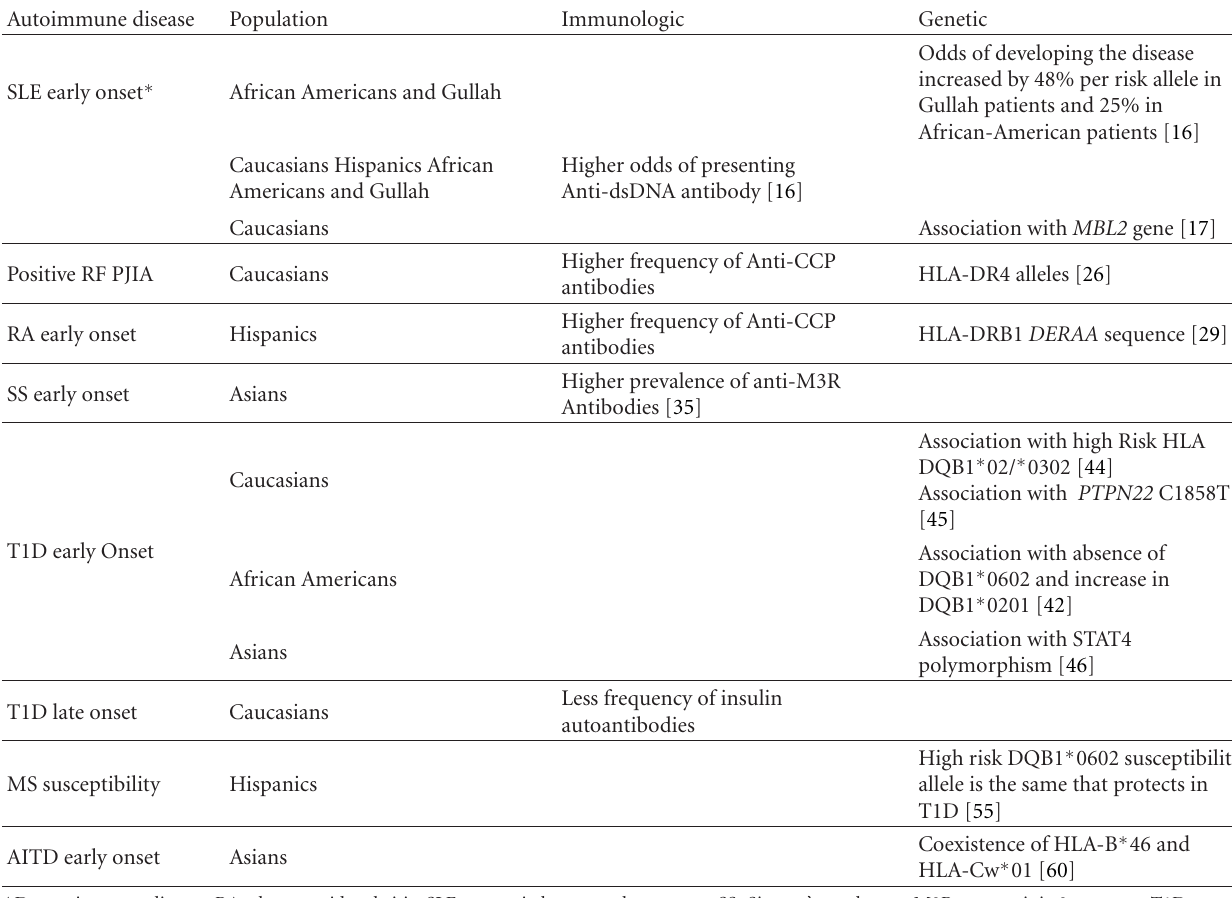
Table 2: Genetic and immunological factors related to age at